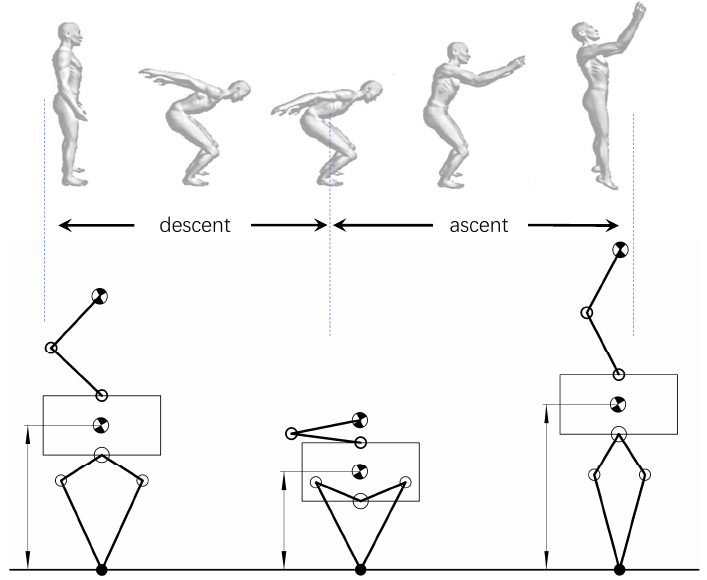
Figure 5. The decomposition motion during vertical